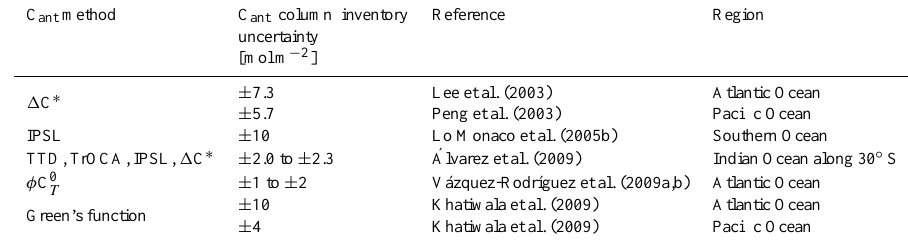
Table A2. Published estimates of uncertainty in the column inventory of C ant .